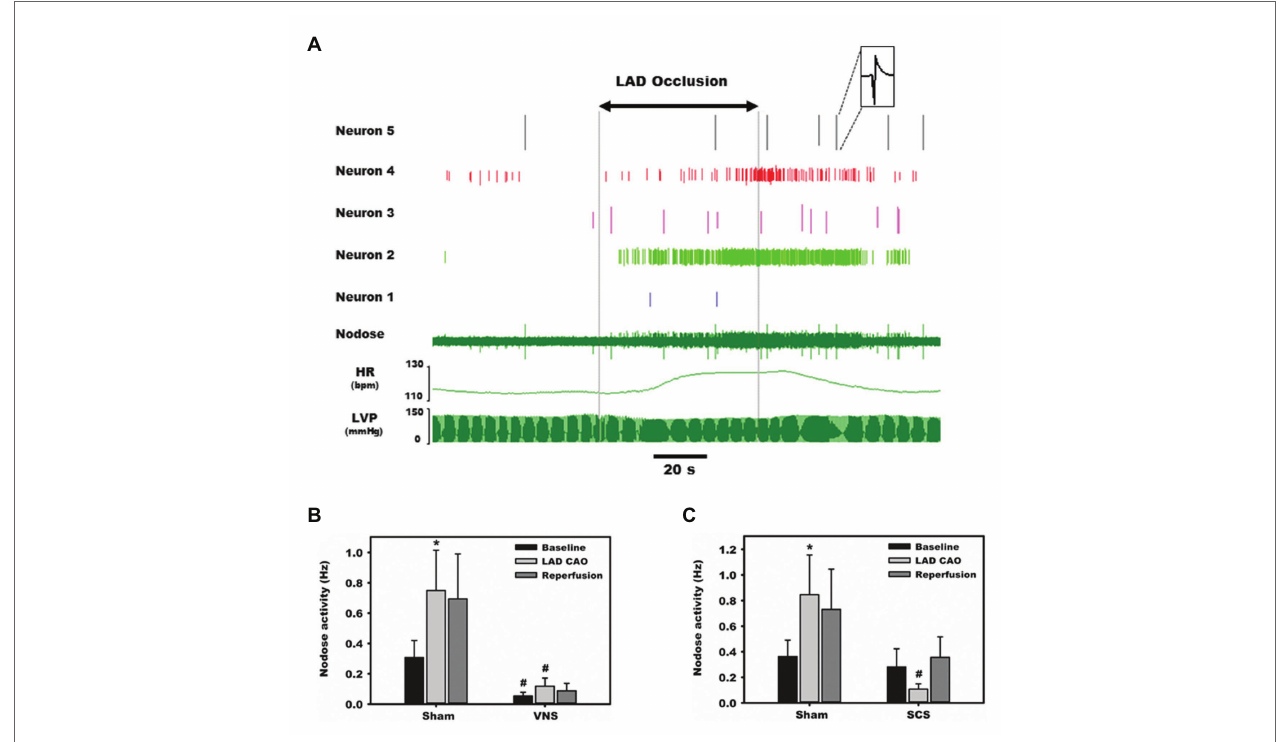
FIGURE 3 | Afferent transduction of ischemia is modulated directly by parasympathetic input as well as remotely. Representative recordings from the nodose ganglia, one of the major parasympathetic afferent ganglia, during occlusion of the left anterior descending (LAD) coronary artery. (A) Activity from five neurons displays substantial heterogeneity in baseline firing frequency and responses to ischemia and reperfusion. (B) Normalized, summative nodose activity at baseline, with LAD artery occlusion, and reperfusion, with and without vagal nerve stimulation. In all settings, animals receiving vagal nerve stimulation (VNS) displayed marked reductions in nodose activity. (C) Spinal cord stimulation also reduces nodose neural activity in response to ischemia stress. Adapted from Salavatian et al. (2017a) with permission. * p < 0.05 from baseline; # p < 0.05 from